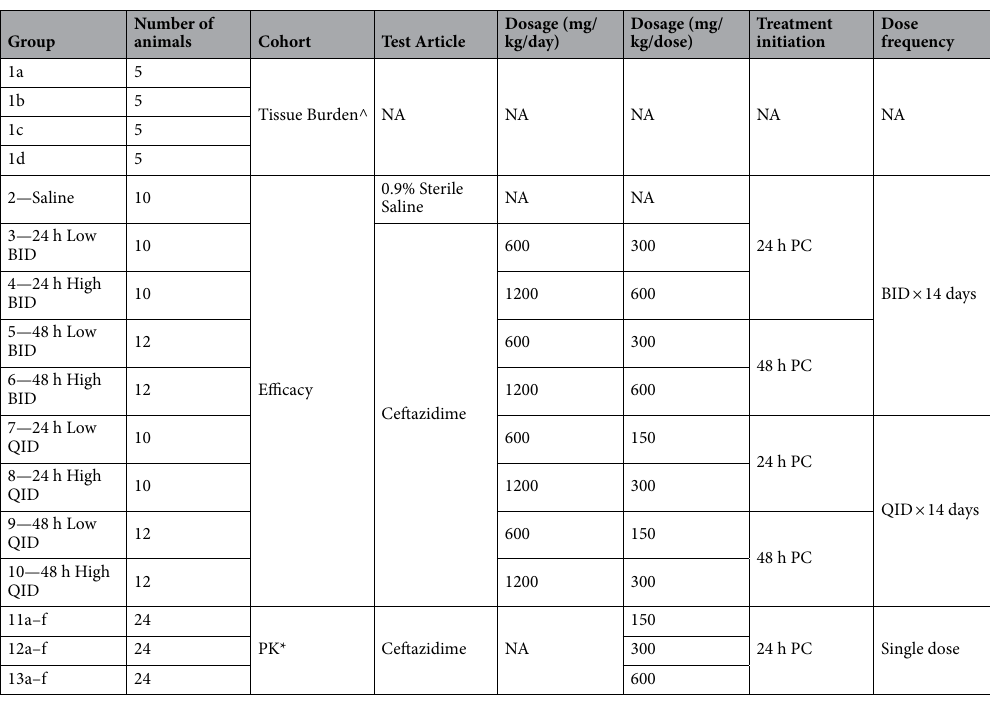
Table 1. Study design—efficacy and PK cohorts. The experimental design. Disease progression was assessed in infected, untreated animals from 24 through 60 h post-exposure. The efficacy of eight distinct